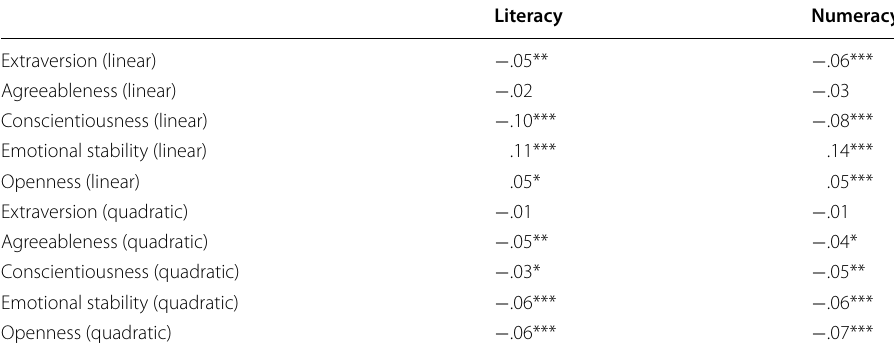
Table 1 Associations between the Big Five scales and basic competencies (literacy and